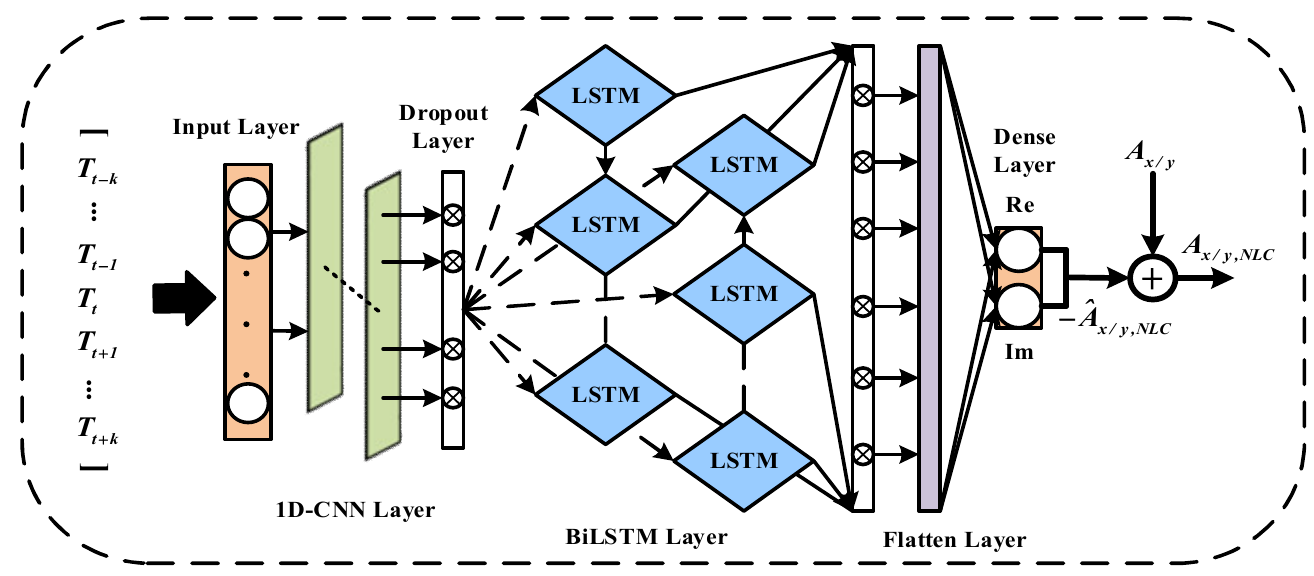
Figure 3. Concrete structure of CNN-BiLSTM neural network.